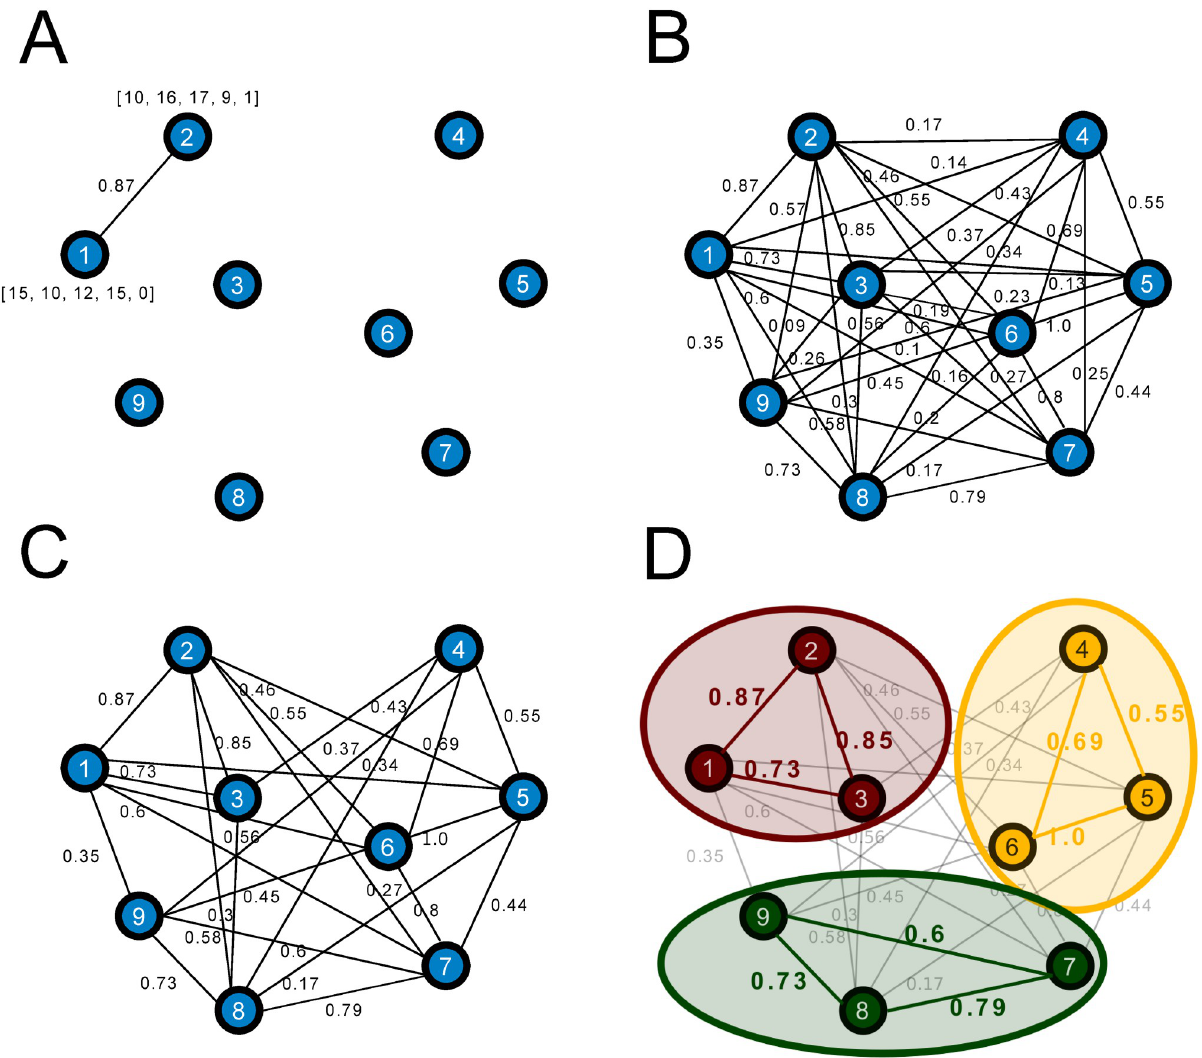
Fig 1. How we build a weighted network of a classroom. Students are represented as nodes in a network. In this example assume 9 students and 3-member groups. A : The first step is to compute the dissimilarity between a pair of students given their attribute vectors. As an example, student 1 and 2 answered the same questionnaire obtaining (15 , 10 , 12 , 15 , 0) and (10 , 16 , 17 , 9 , 1) respectively, 4 values for defining the learning style and the last one for gender. Then the dissimilarity between student 1 and 2 is computed with Eq (1). B : Complete graph after applying the previous procedure for all pairs of students in the classroom to obtain all dissimilarities in the network. C : Reduced network, we remove one third of the total edges (those with lower dissimilarity) to reduce computational cost. D : Resultant partition after fitting several Stochastic Block Models and finding the optimal one with minimum entropy, note that when nodes in the same group have higher values of dissimilarity, then heterogeneous groups are formed.